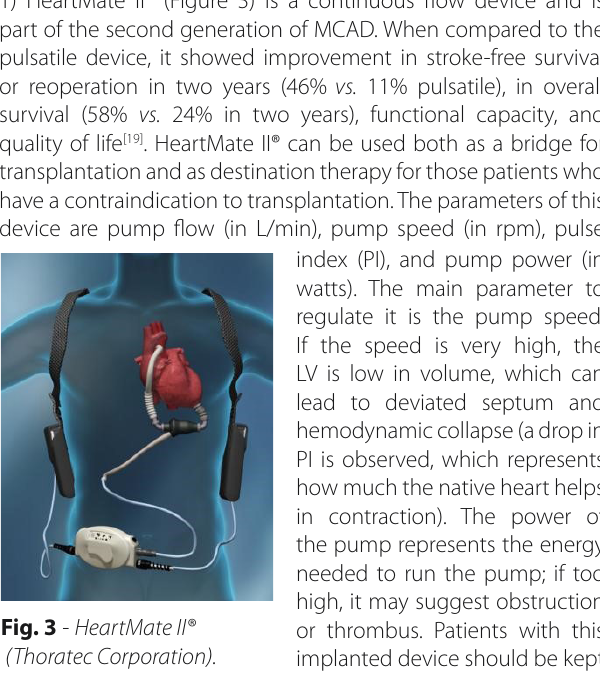
Fig. 3 - HeartMate